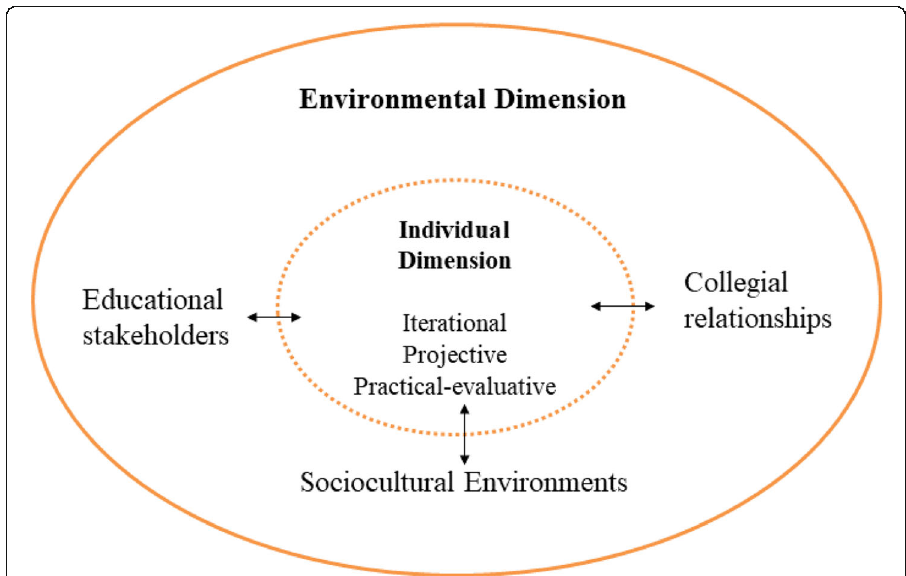
Fig. 1 Two dimensions of